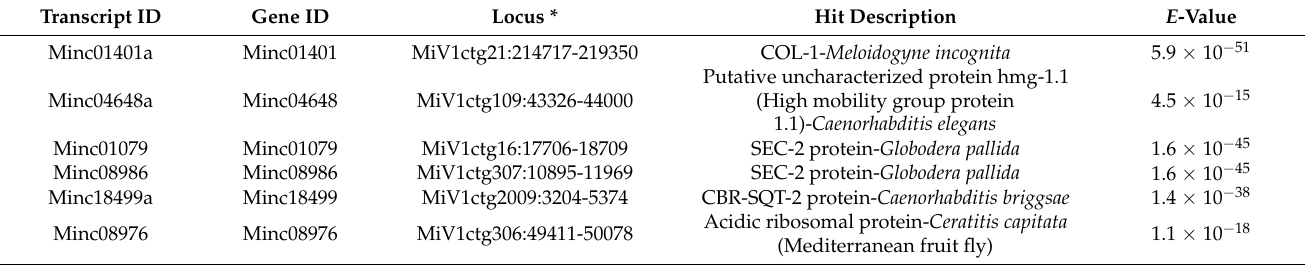
Table 4. Most abundant shared mRNA contigs among 12,803 commonly expressed mRNAs in all stages of M. incognita